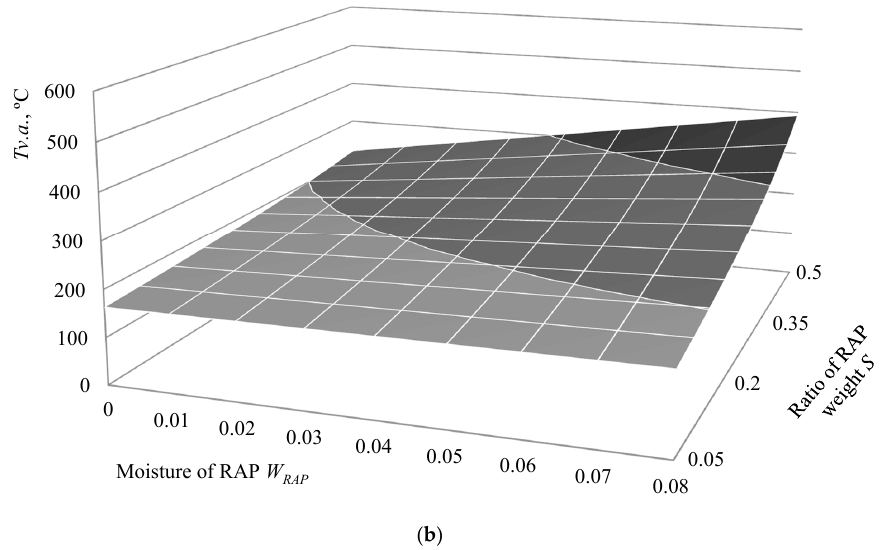
Figure 4. Dependence of superheating temperature of virgin mineral materials on the ratio of RAP weight and moisture of RAP when T RAP is as follows: ( a )—15 °C; ( b )—100 °C.